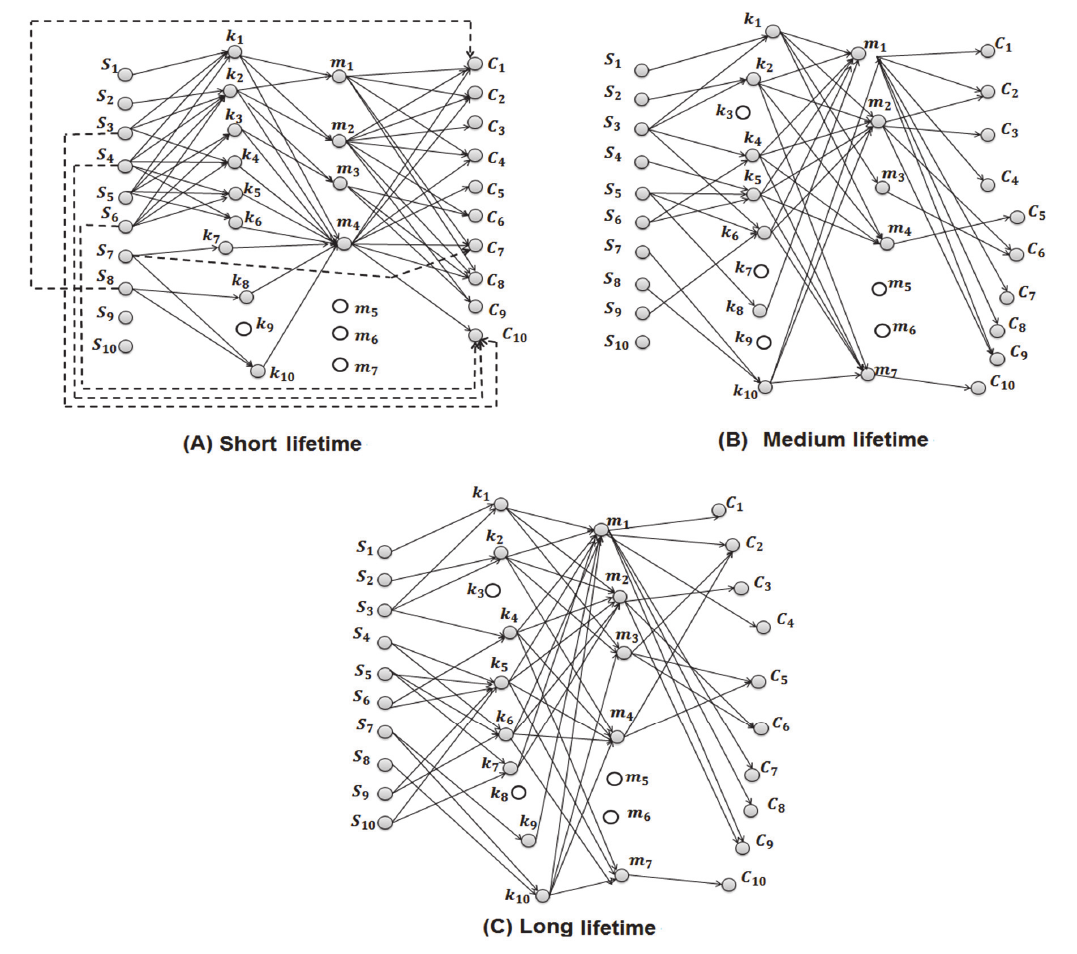
Fig. 8. Some best solutions obtained for three products categories with different